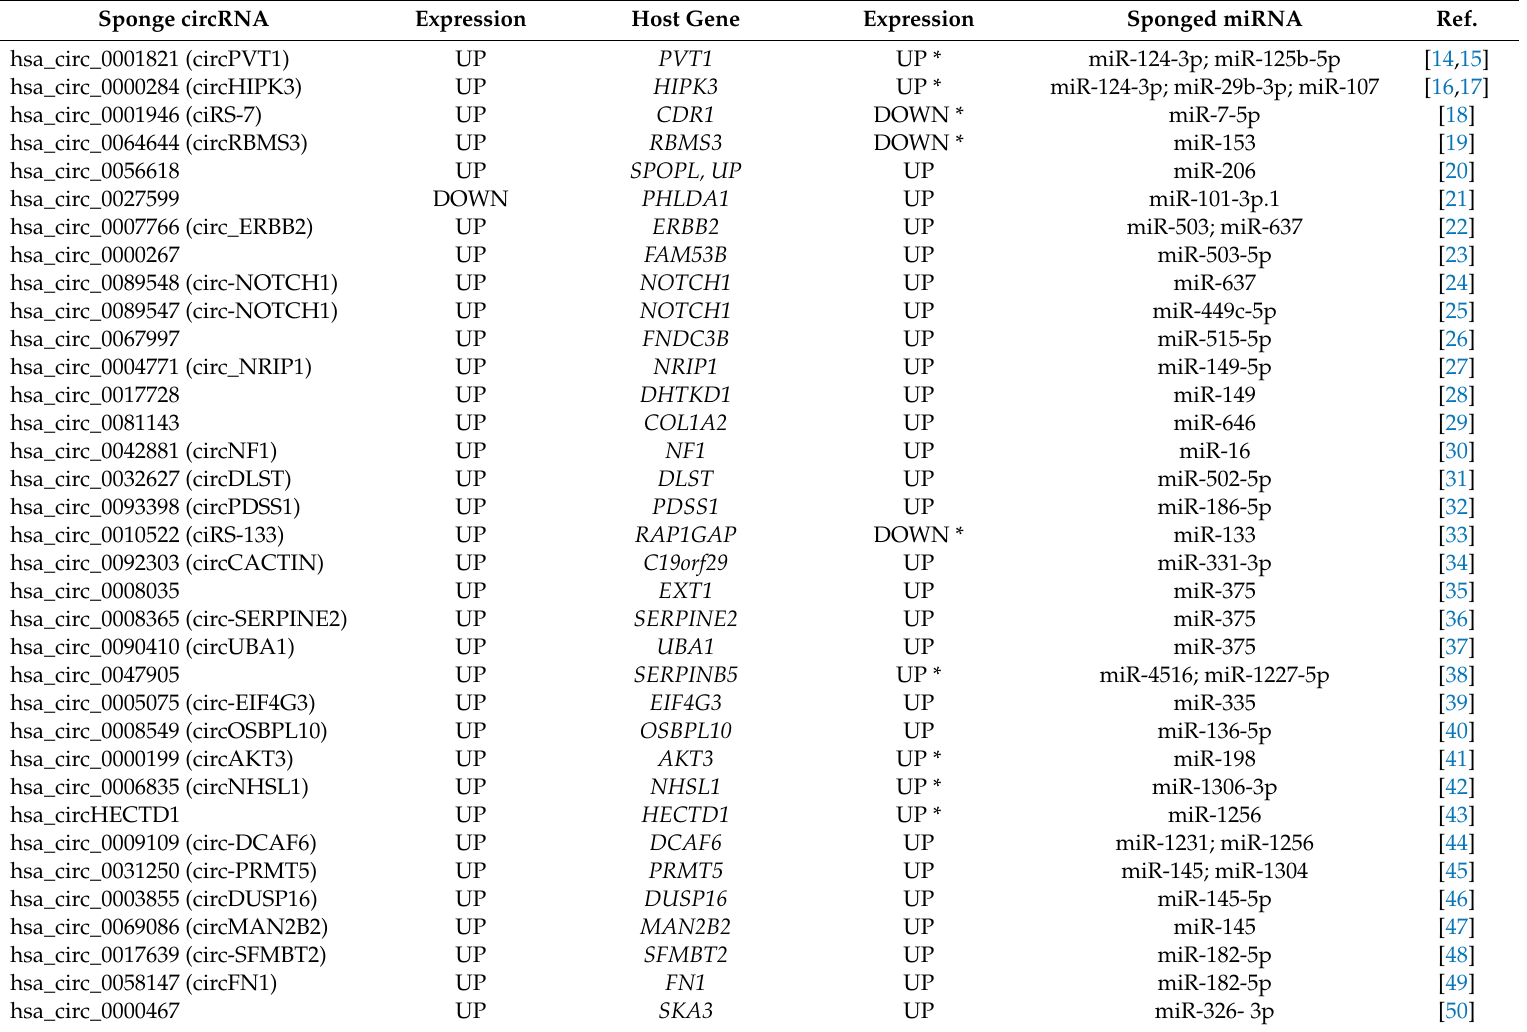
Table 1. Description of the sponge circular RNAs (circRNAs) in gastric cancer and their target microRNAs (miRNAs). Sponge